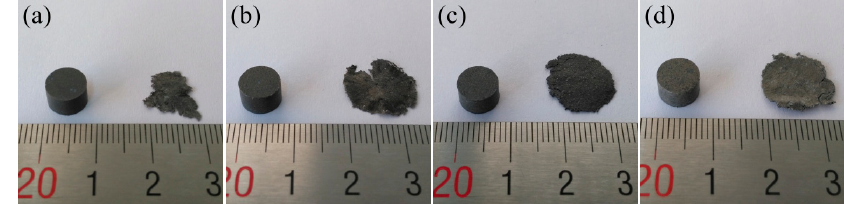
Figure 8. Samples before and after SHPB tests of PTFE/Ti/W composites: ( a ) 68PTFE/32Ti; ( b ) 47PTFE/23Ti/30W; ( c ) 34PTFE/16Ti/50W; ( d ) 20PTFE/10Ti/70W.